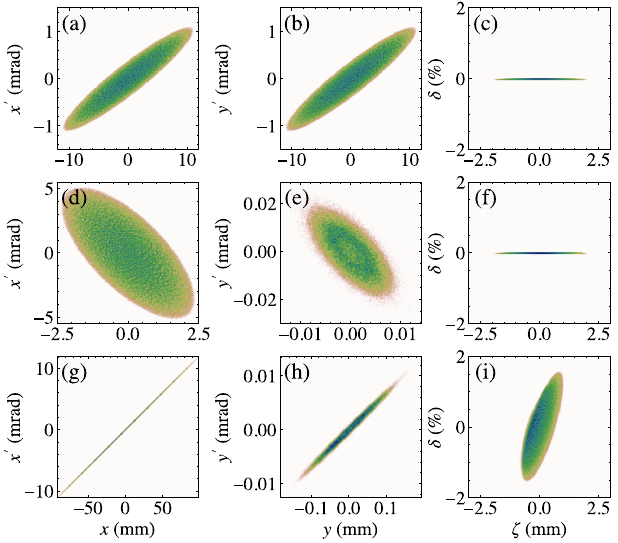
FIG. 5. Horizontal (a,d,g), vertical (b,e,h), and longitudinal (c,f,i) phase-space upstream of the RFBT (a,b,c), upstream of the EEX (d,e,f), and at the exit of the EEX (g,h,i).